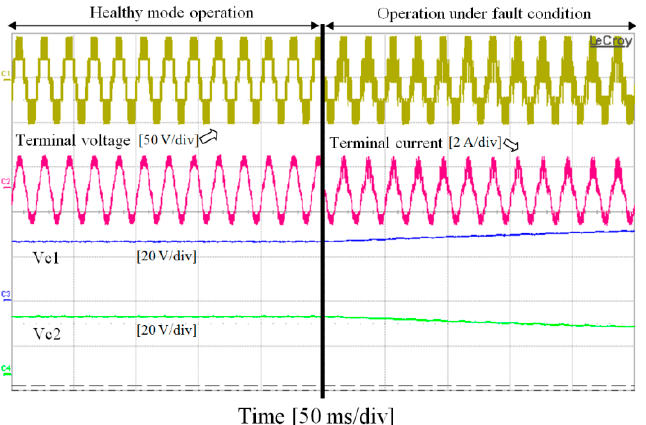
Figure 9. Experimental setup.